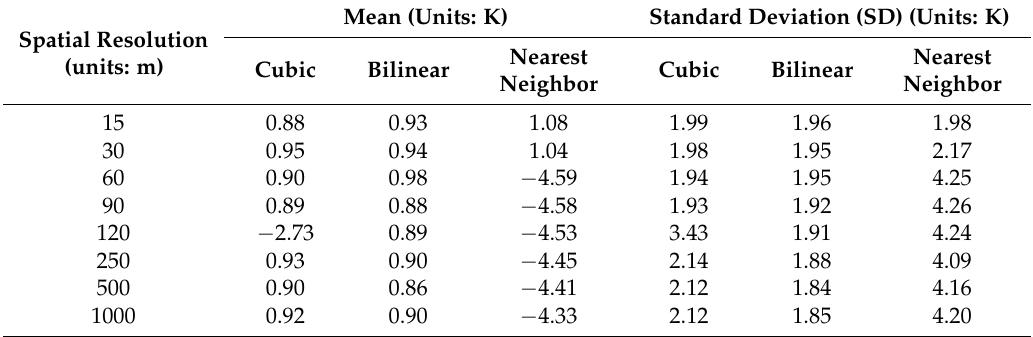
Figure 4. Scatter plots between observed and simulated ASTER LST datasets at mountain and urban areas on date 04/28/2007. Temperature units: K. Spatial resolution: 15 m. Table 2. Basic statistics in the difference maps between observed ASTER LST and simulated ASTER LST data (observed–simulated) for image date 04/28/2007, by using Cubic Convolution, Bilinear Interpolation, and Nearest Neighbor resample methods.